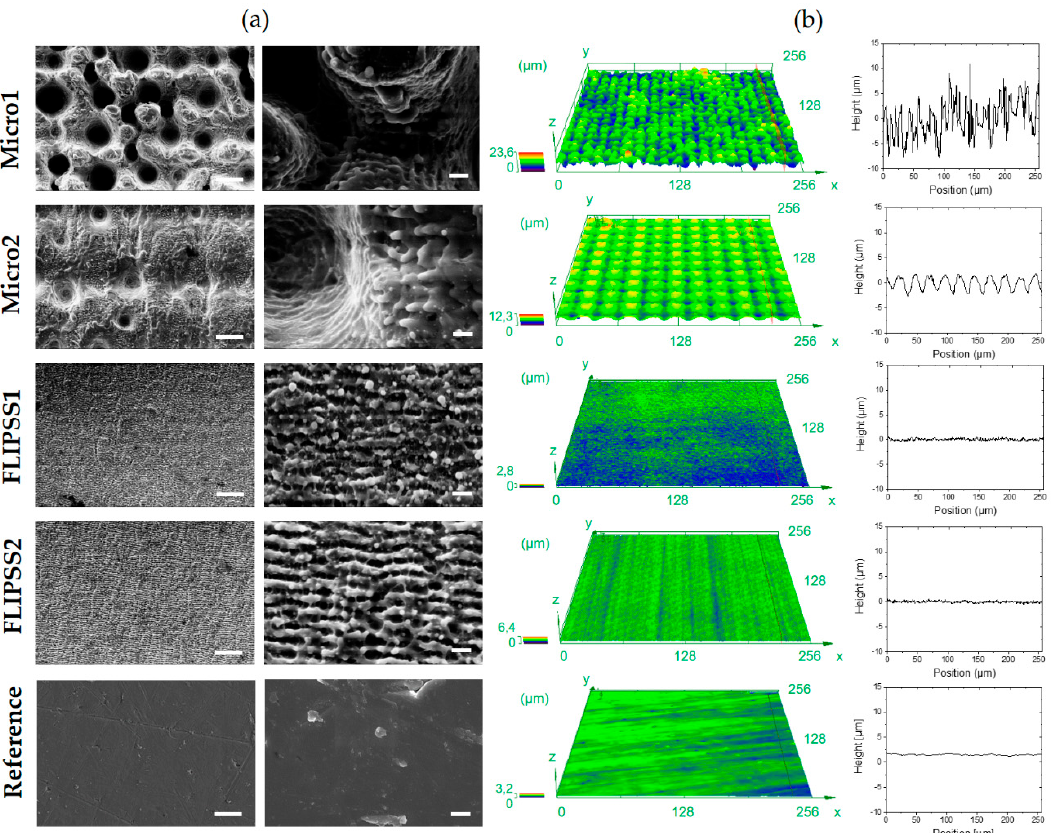
Figure 1. Surface characterization of laser-structured Ti6Al4V specimens. ( a ) Scanning electron microscope images (StereoScan360), scale bars left: 10 µm, right: 1 µm and ( b ) confocal laser scanning microscope images (LEXT OLS 4000), square side length: 256 µ m, with corresponding elevation profile of laser irradiated structures and polished Ti6Al4V